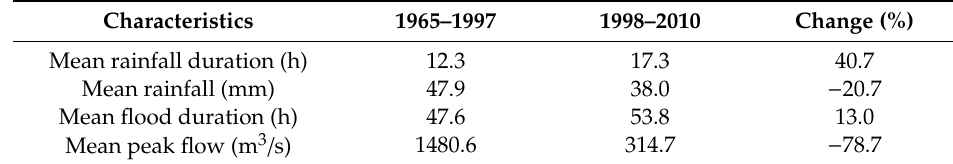
Table 7. Characteristics of flood events in different stages of Gushanchuan basin.